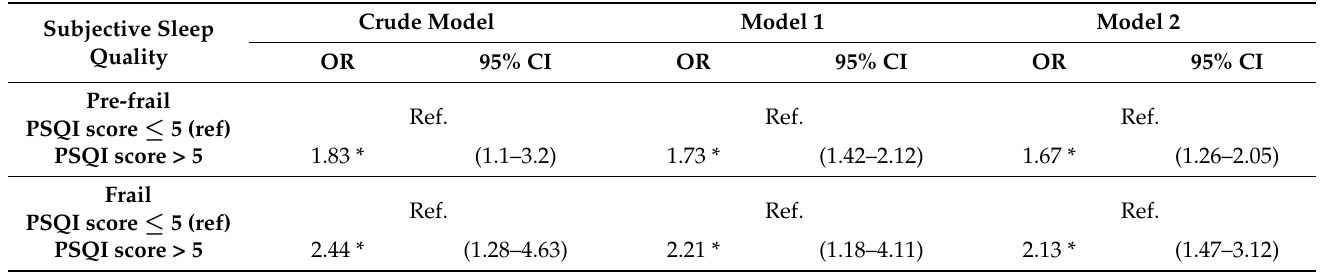
Table 2. Association between sleep quality and frailty